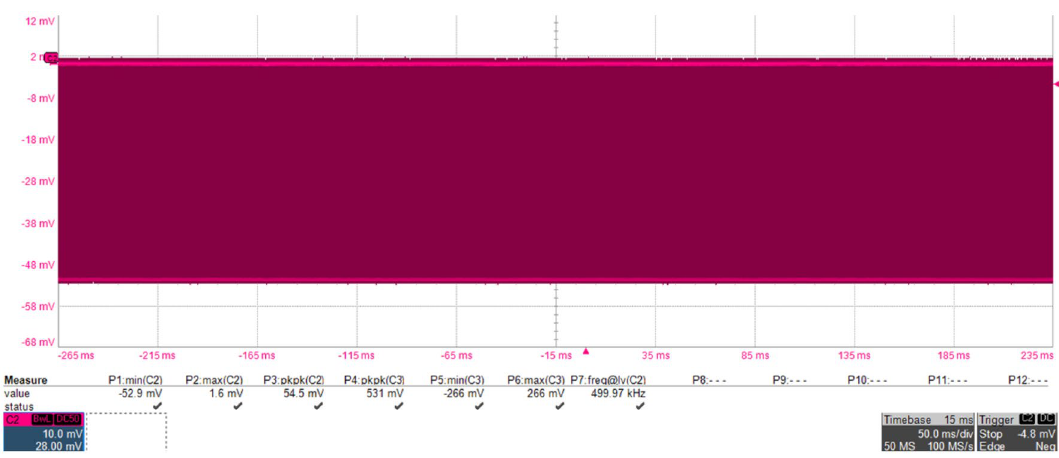
Figure 4. Output signals of the GaN-HEMT power amplifier in normal working